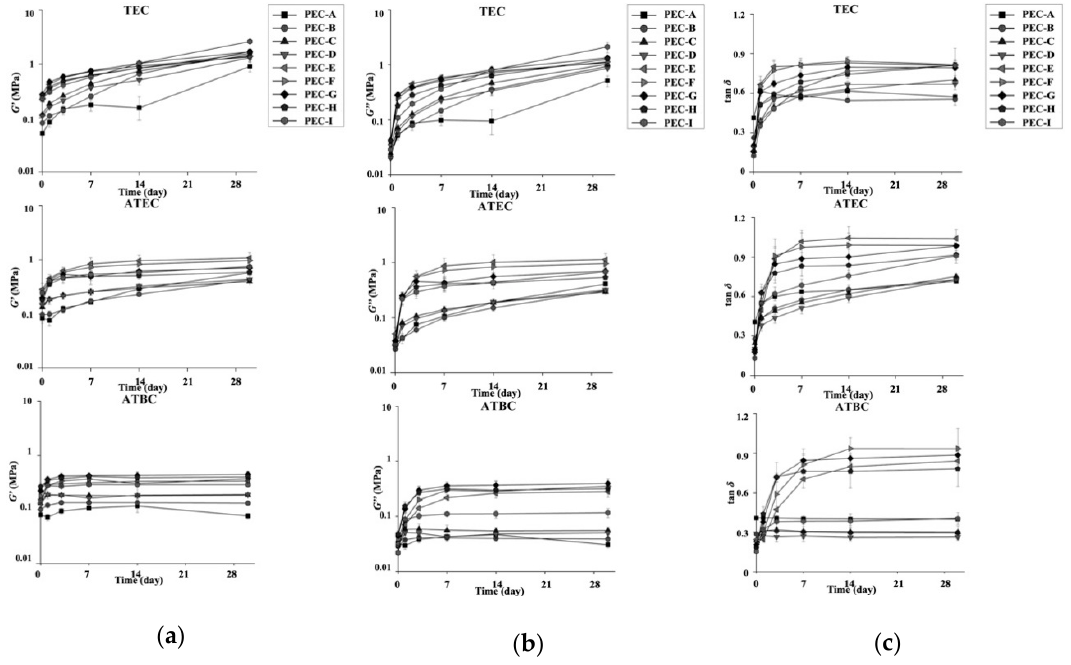
Figure 6. Variations of viscoelastic parameters with time of immersion at 1 Hz. ( a ) Storage modulus ( G ′ ) values; ( b ) loss modulus ( G ″ ) values; and ( c ) loss tangent (tan δ ) values.